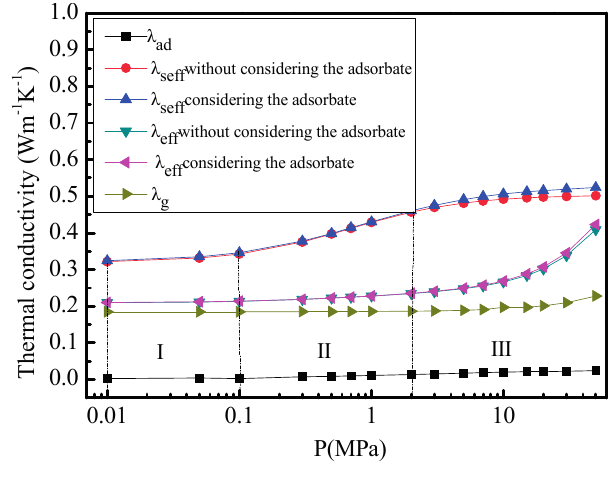
Figure 7. Varying thermal conductivity at different pressures and 298.15